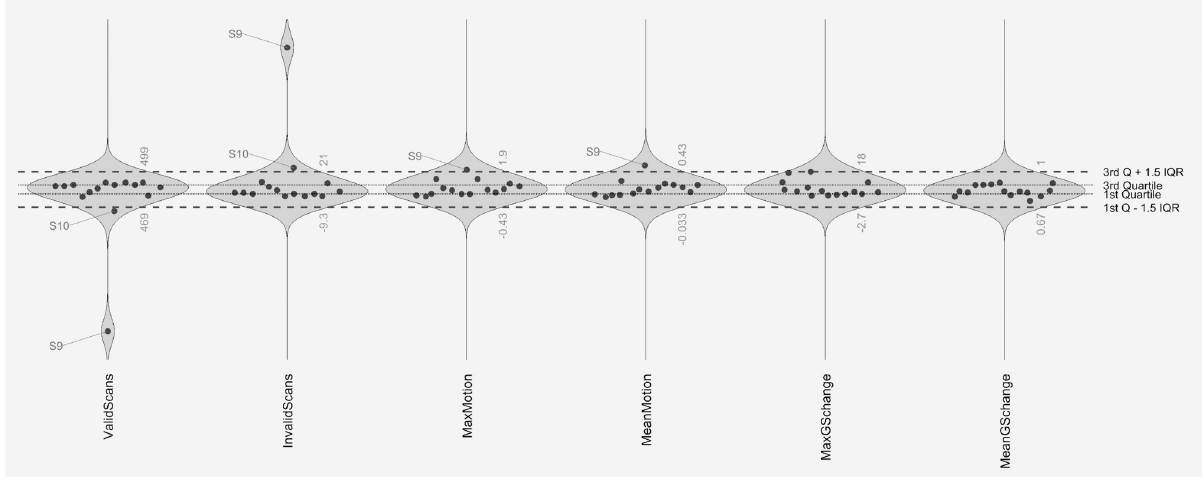
Fig 2. Overview of quality assurance measures for the resting-state fMRI subsample. Abbreviations: MaxGSchange, maximum change of the global BOLD signal; MeanGSchange, mean change of the global BOLD signal; MaxMotion, maximum amount of motion; MeanMotion, average amount of motion; Q, quartile; IQR, interquartile range, S, subject.